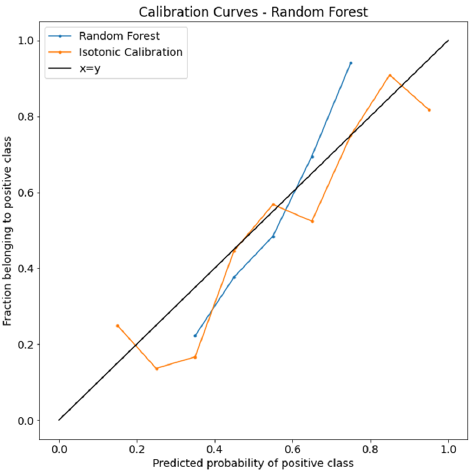
Figure 3. Isotonic calibration curves of the random forest algorithm. Calibration curves compare how the probabilistic predictions of the RF binary clas- sifier are calibrated. The true frequency of the positive label was plotted against its pre- dicted probability for binned predictions. The x-axis represents the average predicted probability in each bin. The y-axis is the fraction of positives. 3.4. Case Discussion Two women who visited our hospital were presented as case studies (Figure 4). Both patients were diagnosed with HLD L4/5 on opposite sides. Both patients had lower-extrem- ity pain, which was rated on the VAS. Infrared thermal images were taken, objectively showing that the temperature change appeared along the dermatome of the diagnosed HLD-related level. The temperature difference was larger in the case of severe pain, show- ing that thermal imaging can visualize both the location of a lesion and severity of pain.